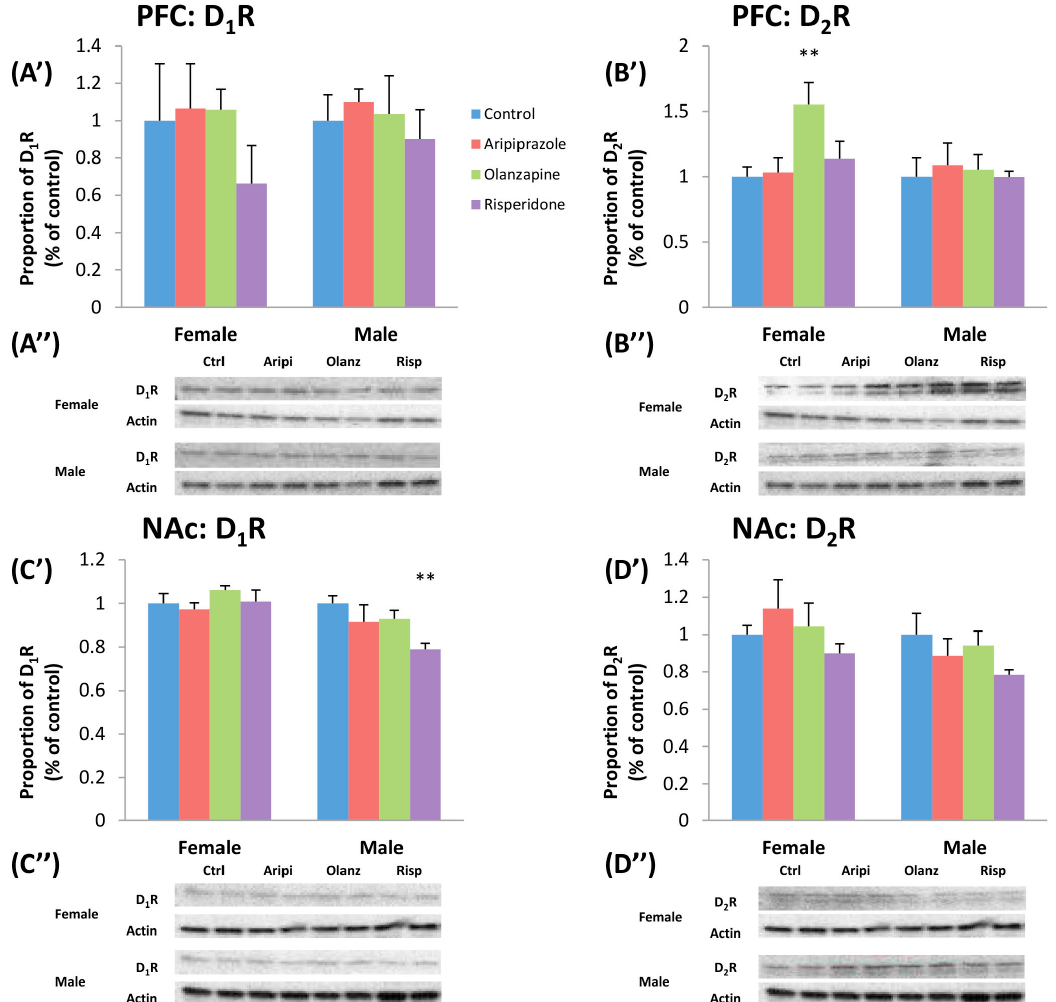
Figure 4. Effects of three APDs on D 1 and D 2 receptor (D 1 R and D 2 R) expression levels in the PFC